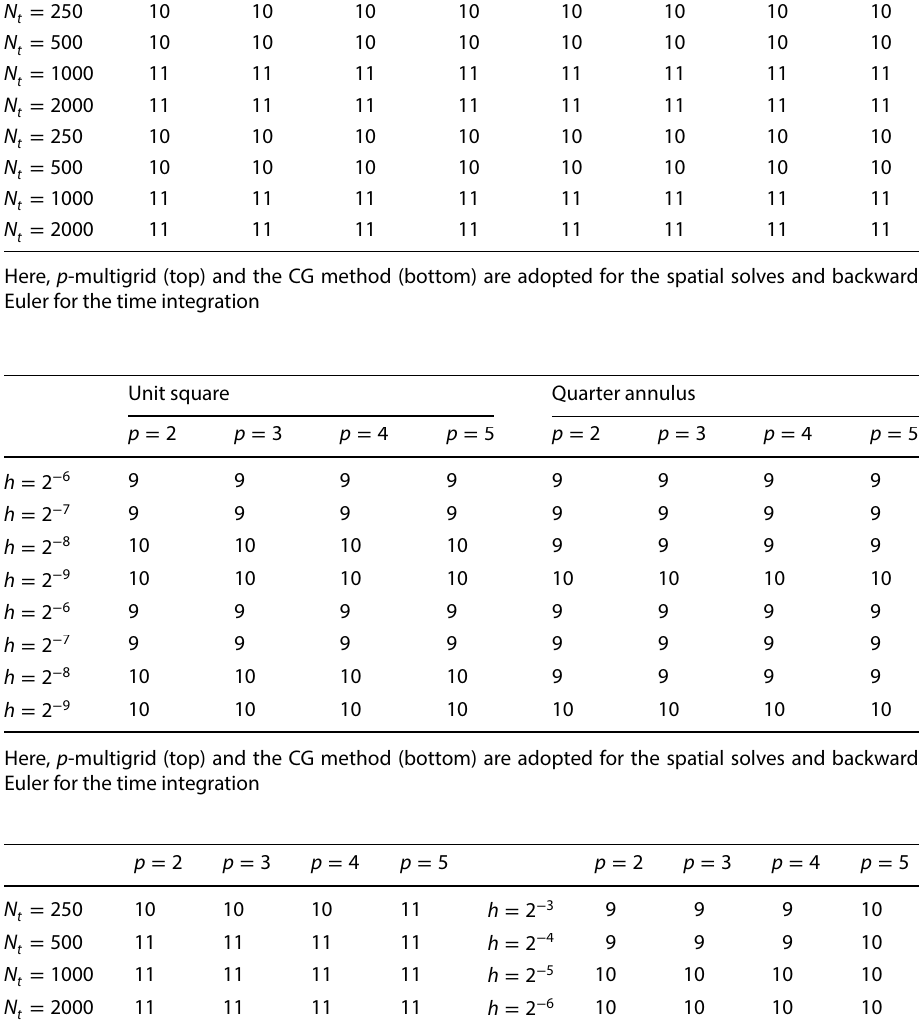
Table 1 Number of MGRIT iterations for solving Eq. (1) on the unit square and a quarter annulus when adopting V-cycles for a varying number of time steps